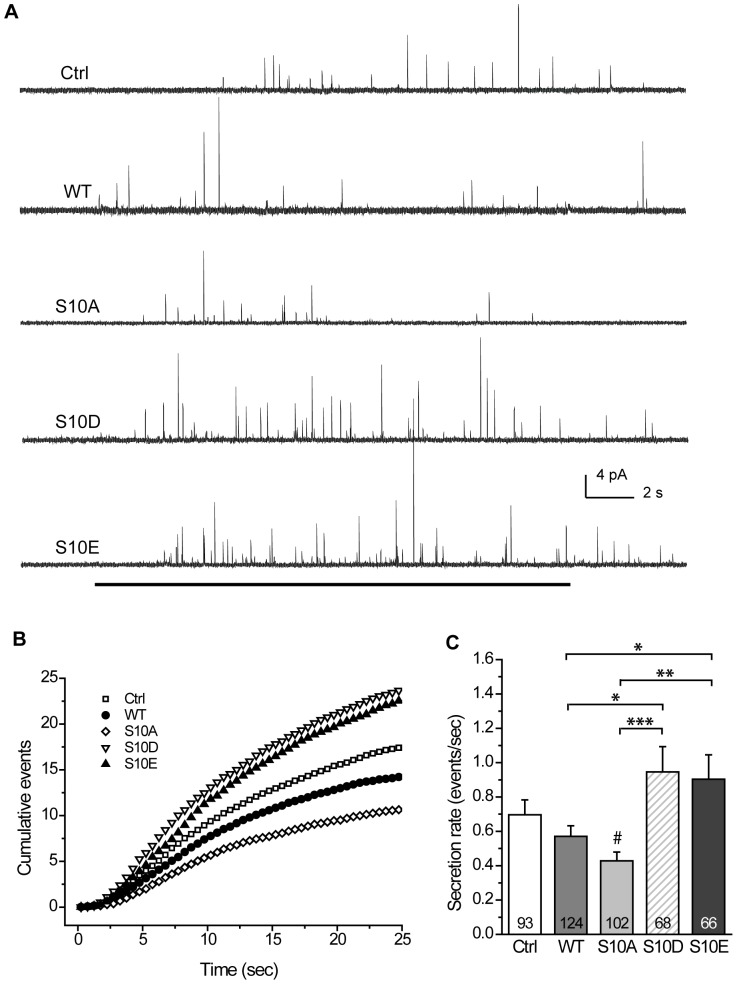
Secretion events in PC12 cells that overexpress CSP and its phosphomutants.
A, Representative amperometric recordings of secretion events in PC12 cells that overexpress control vector (Ctrl), wild-type (WT), S10A, S10D, or S10E CSPα. Black line at bottom indicates the duration of KCl application (20 sec). B, Cumulative events for groups described in (A). Cumulative counts were normalized by cell numbers. C, The secretion rate was acquired from the onset of KCl application to the end of the recording (total 25 sec) by using the cellular mean method. Numbers in bars indicate number of cells recorded for each group. Total 1092–1771 events for those cells.